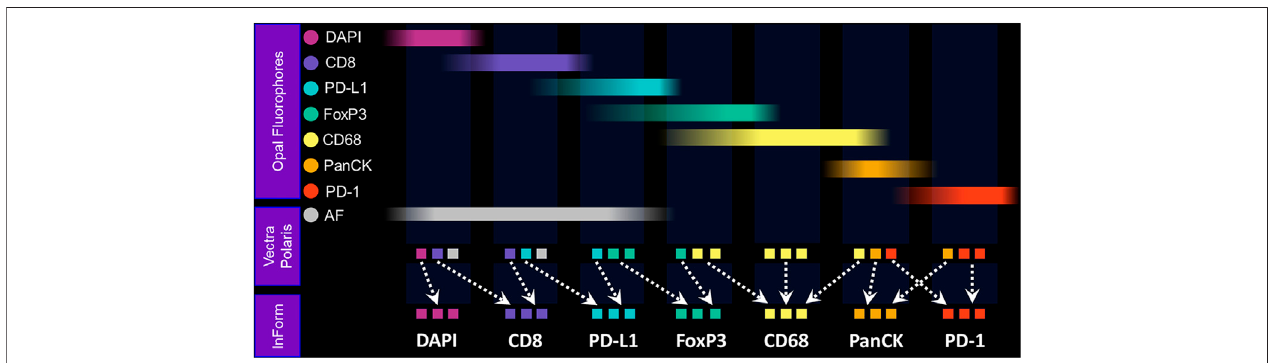
FIGURE 4 | Fundamentals of MOTiF imaging and spectral unmixing. With the MOTiF work fl ow, a tissue is stained with Opal fl uorophores using a Leica BOND RX autostainer. The 6-plex, 7-color assay is then imaged using the Vectra Polaris slide scan protocol, wherein whole-slide scan images can be acquired in 10 min. Using inForm, designated library slides are used to isolate the exact spectral signature of each fl uorophore to properly unmix each whole-slide composite image, as well as isolate and remove tissue auto fl uorescence. Spectral unmixing of signals is key to the Phenoptics technology and critical to ensuring accurate data for analysis.